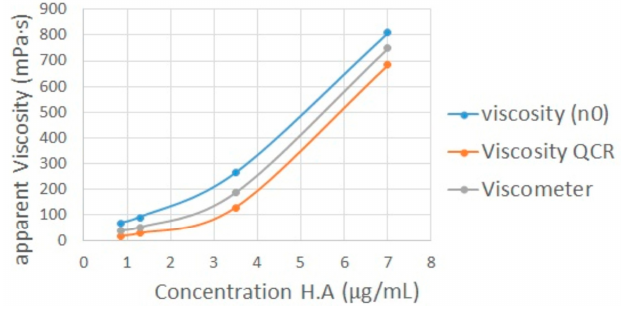
Figure 9. Apparent viscosity obtained by Rouse model vs. viscometer measures.